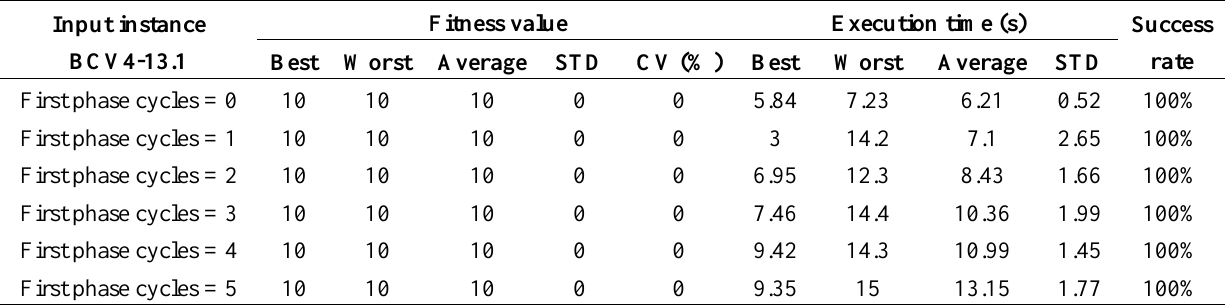
Table 17. Investigating the effect of first phase’s number of cycles for input instance,